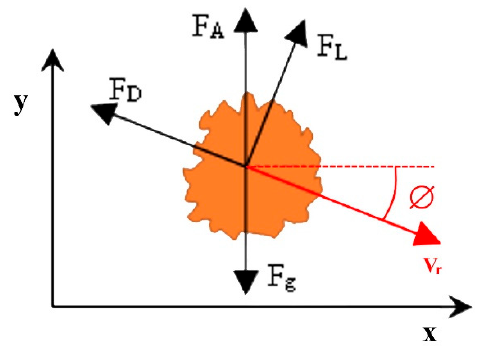
Figure 16. Force diagram of a particle.